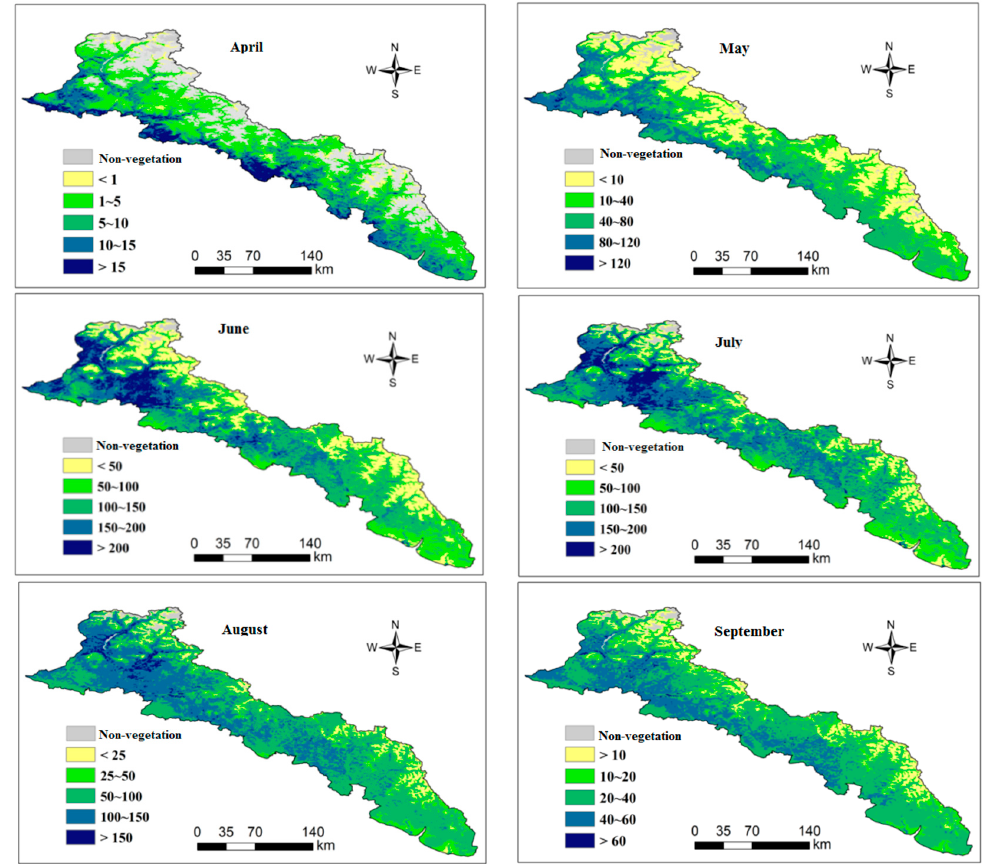
Figure 3. Distributions of GPP in the growing season in the Altay Mountains.